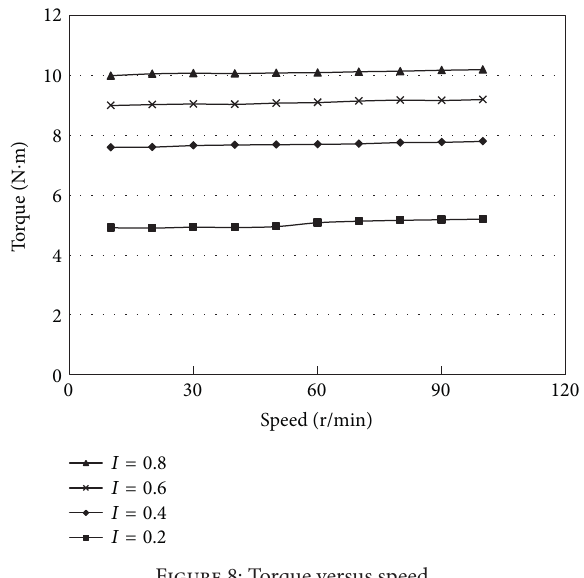
Figure 8: Torque versus